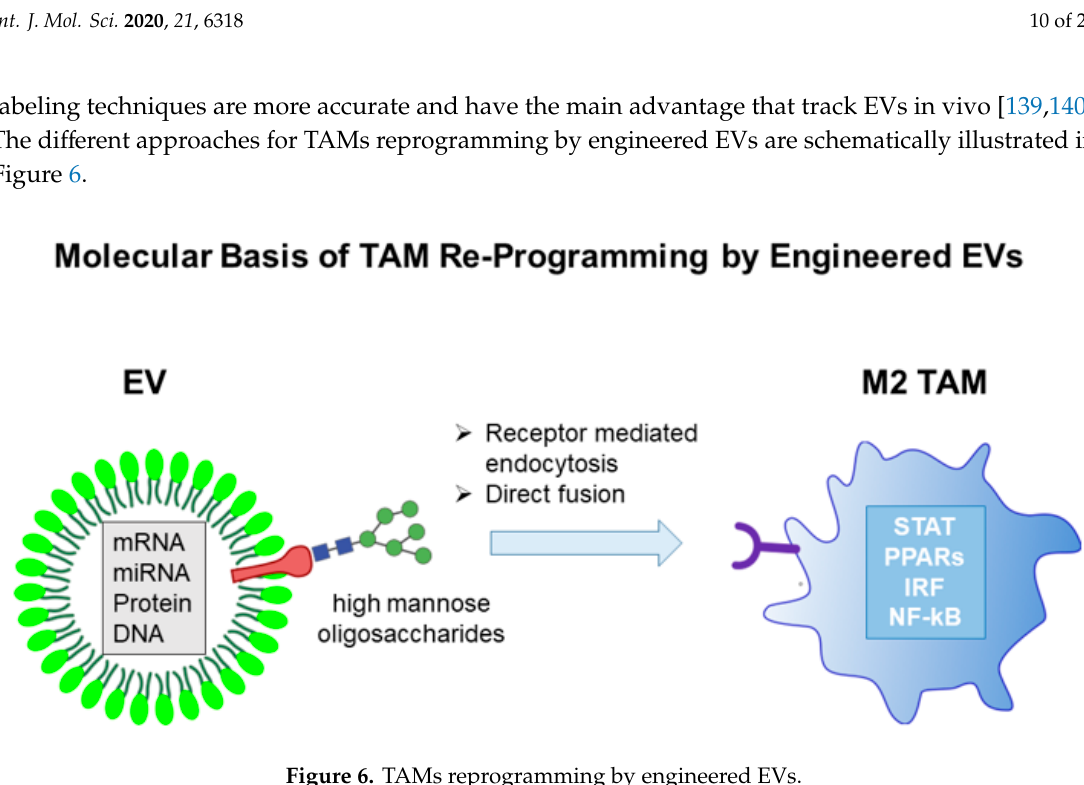
Figure 6. TAMs reprogramming by engineered EVs.